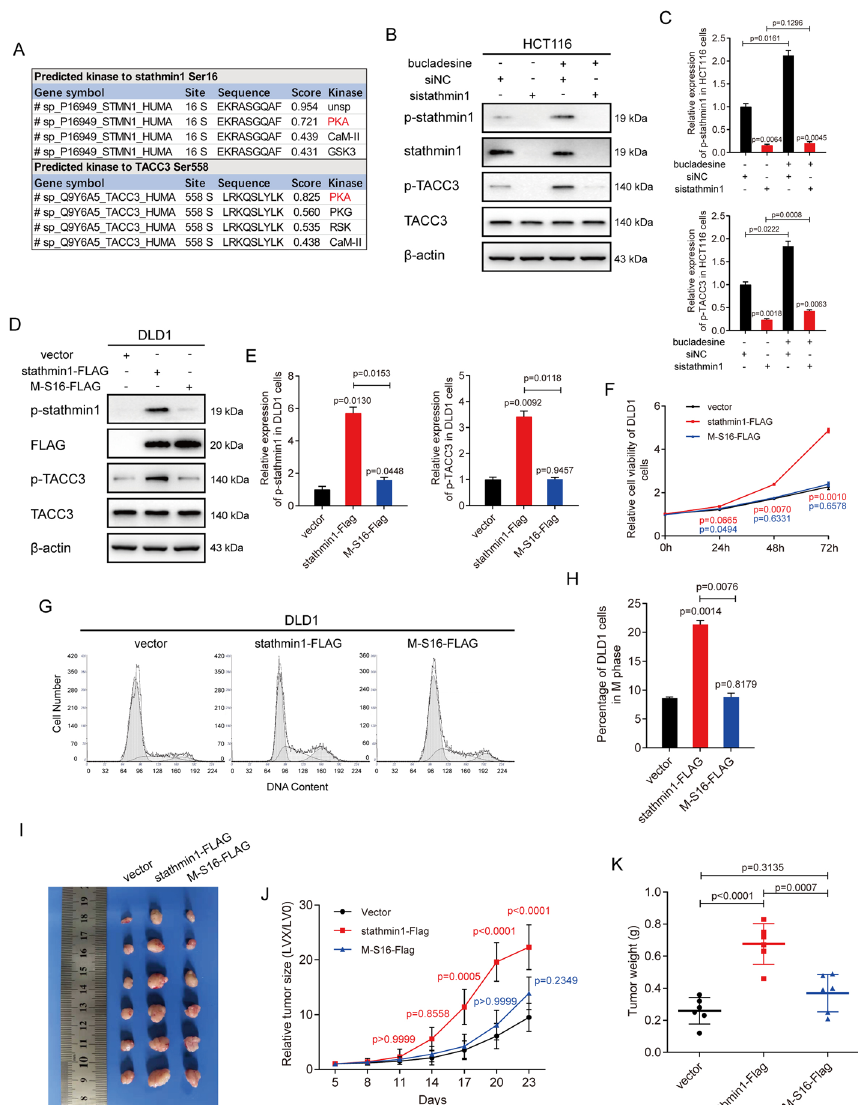
Fig. 5 Phosphorylation of stathmin1 at Ser16 facilitates phosphorylation of TACC3 at Ser558. A Prediction of potential kinases targeting stathmin1 at Ser16 and TACC3 at Ser558 using the NetPhos 3.1 database. PKA was found to target both of these proteins at the indicated sites. B HCT116 cells were transfected with stathmin1-specific or control siRNAs (final concentrations, 20 nM). Cells were treated with 100 μM bucladesine 4 h before harvesting and harvested 48 h after transfection. The levels of indicated factors were determined by immunoblotting. C Relative levels of expression of the proteins indicated in B . D DLD1 cells were transfected with pCMV-stathmin-FLAG, pCMV-stathmin1-M-S16-Ala-FLAG, or pCMV-FLAG vector (final vector concentrations, 2 μg/ml) and harvested 48 h later transfection. The levels of the indicated factors were determined by immunoblotting. E Relative expression levels of the proteins indicated in D. F DLD1 cells were transfected with vectors as shown in D . Cell viability was measured using MTS assays 0, 24, 48, and 72 h after transfection. G DLD1 cells were transfected with vectors as shown in D . Cell cycle progression was analyzed by flow cytometry 48 h after transfection. H Percentage of cells in G in mitotic phase. I Representative images of tumors formed by DLD1 cells with indicated stable transfections. J The growth curves of the tumors formed by the indicated DLD1 cells ( N 6 mice per group). K Weight differences in tumors formed by the = indicated DLD1 cells ( N 6 mice per =